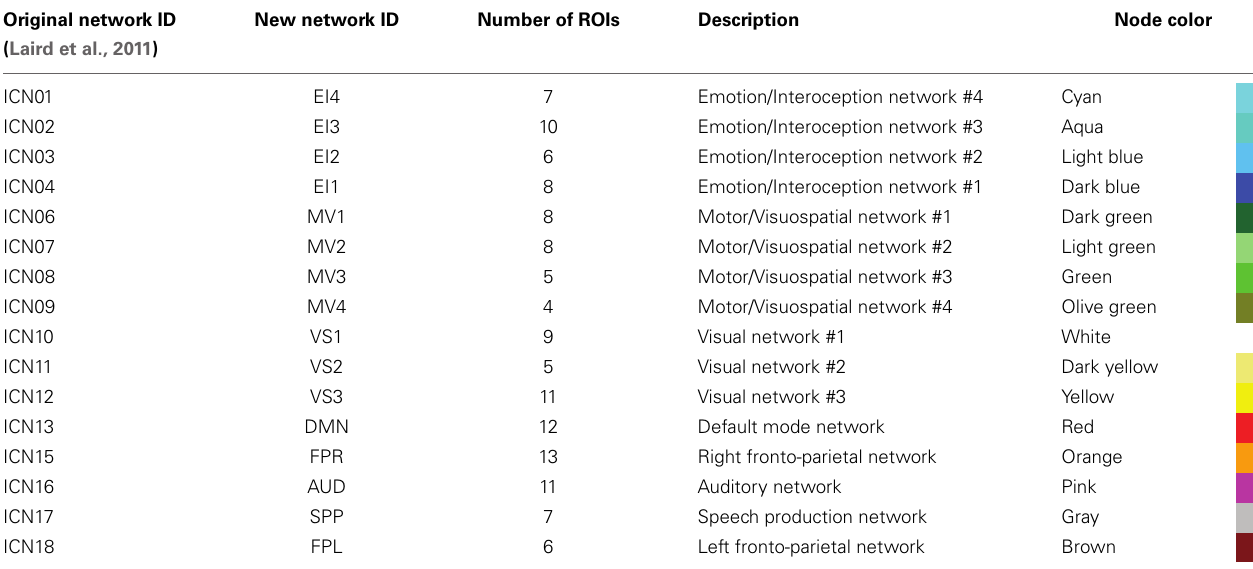
Table 2 | Summary of correspondence between Craddock Atlas ROIs and Laird Network